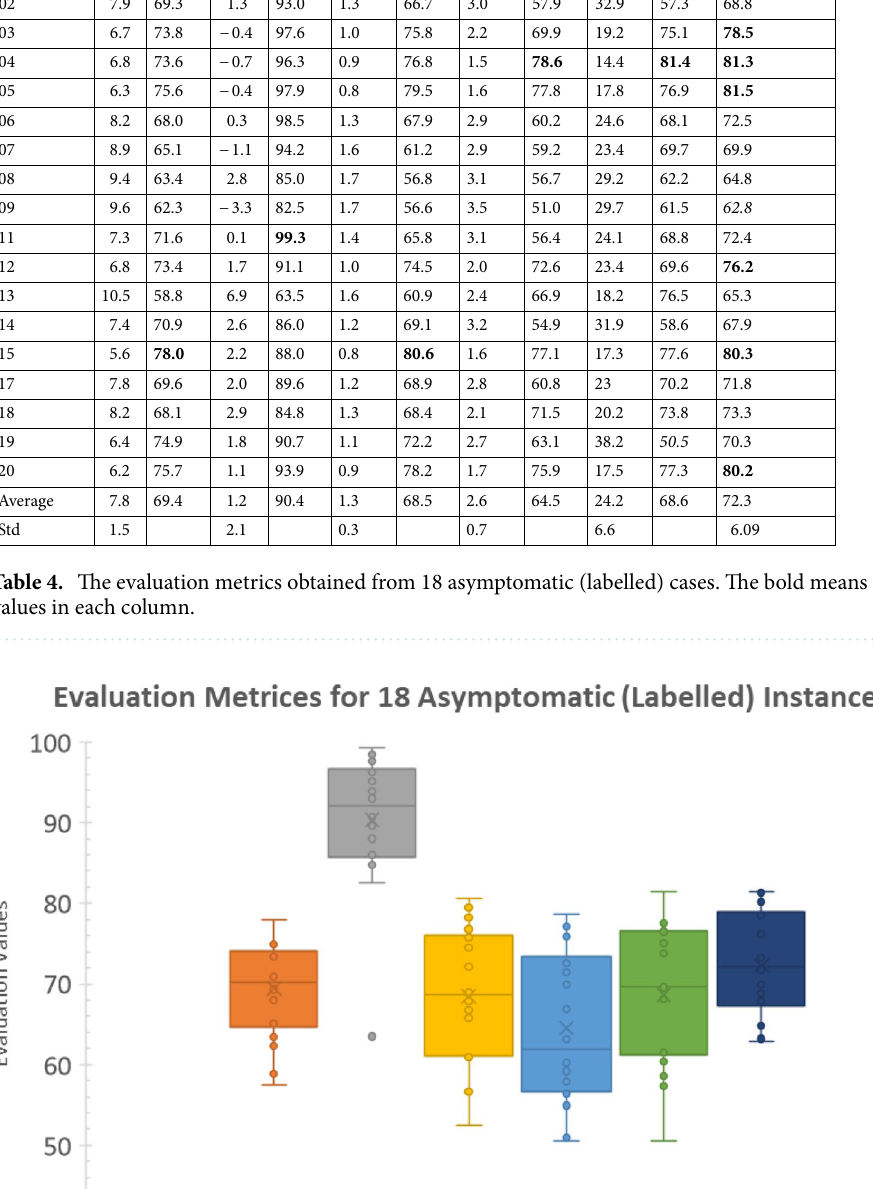
truth, and respective surface, rendered with false colors, representing errors (in mm).